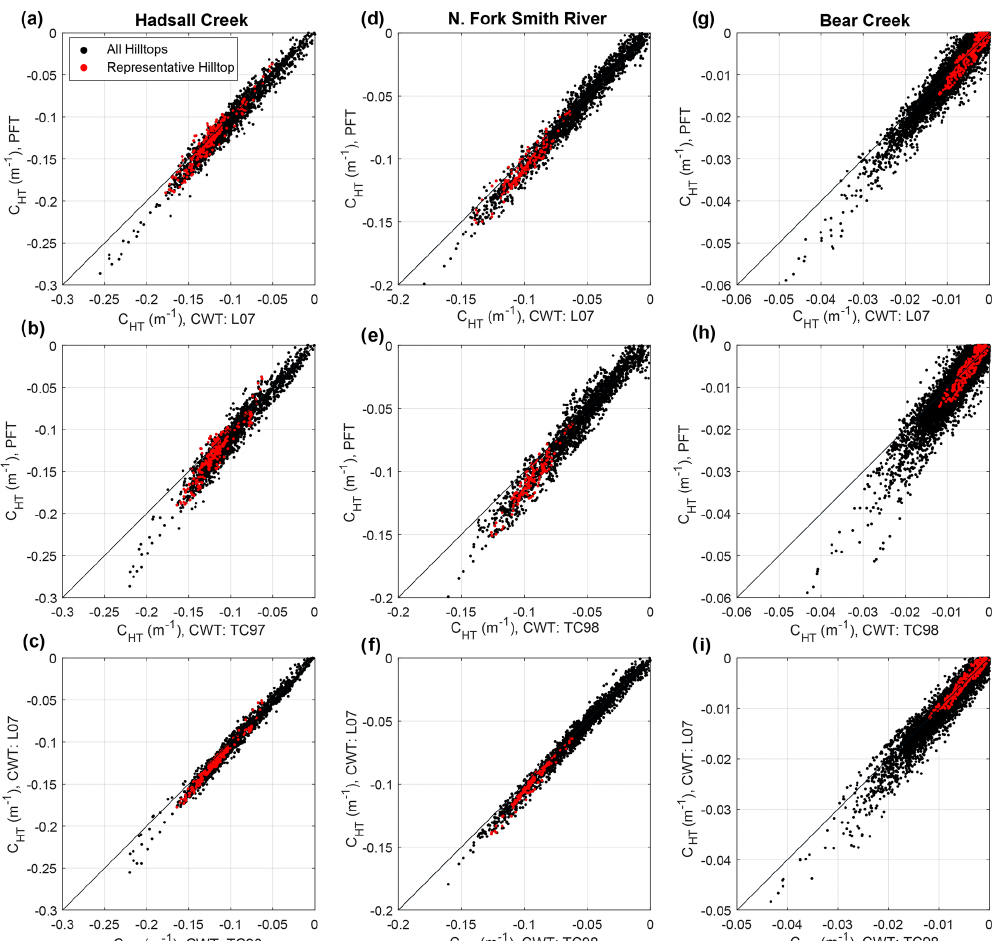
Figure 5. Comparison of C HT calculation methods for λ = 15m. Black dots correspond with curvature measured at nodes for all mapped hilltops (roads, landslides, valley bottoms, etc. removed ). Red points correspond with the representative hilltop nodes (Fig. 1). Perfect agree- ment between measurement techniques would plot as 1 : 1 line (black line). Recall that more positive (lower magnitude) C HT corresponds with more gentle hillslopes (upper-right corner). See text for details. L07: Lashermes et al. (2007); TC98: Torrence and Compo (1998).